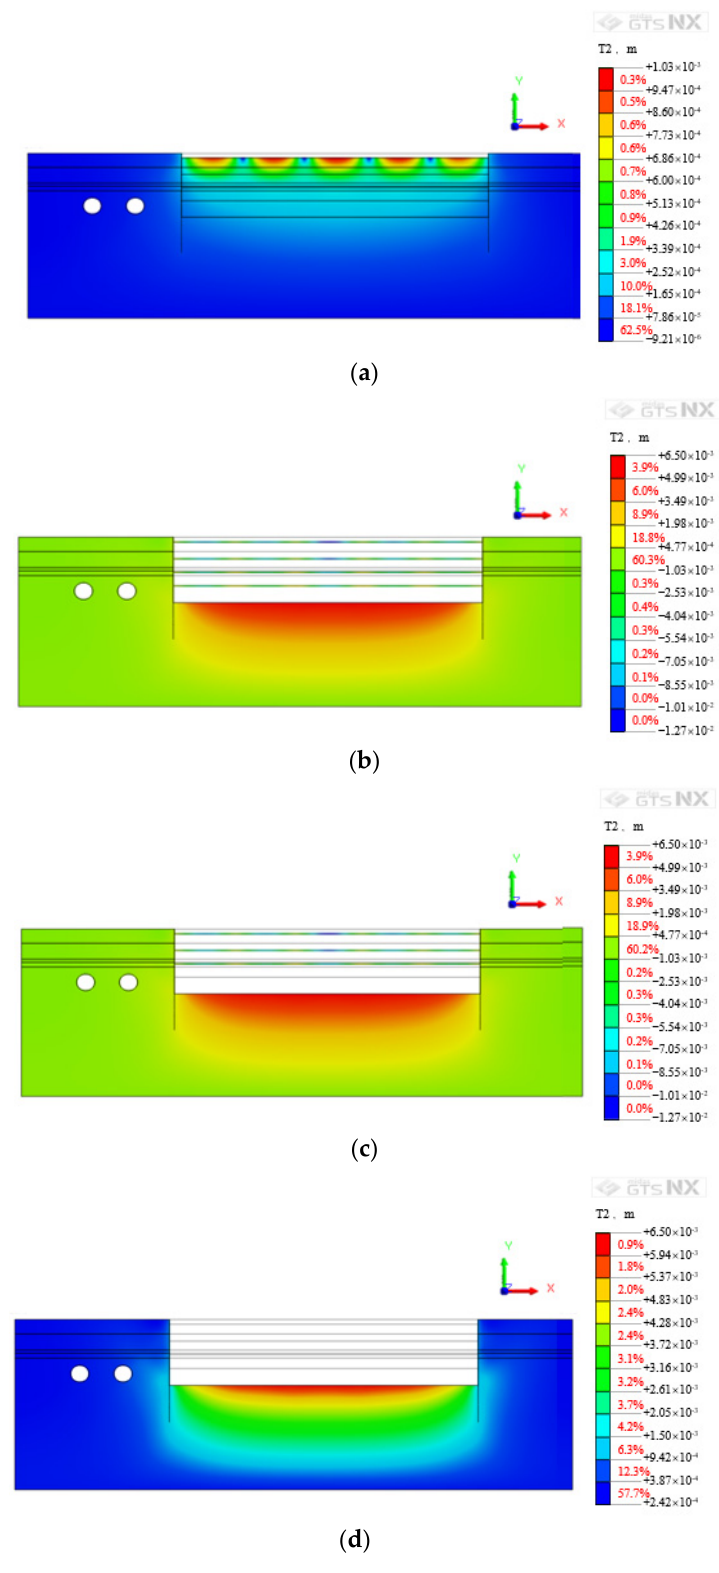
Figure 9. Vertical deformation caused by construction of section B. ( a ) Excavate to − 2.20 m elevation. ( b ) Excavate to the design elevation of the bottom of the foundation pit. ( c ) The inner supports on the fourth layer are removed. ( d ) All inner supports are removed.